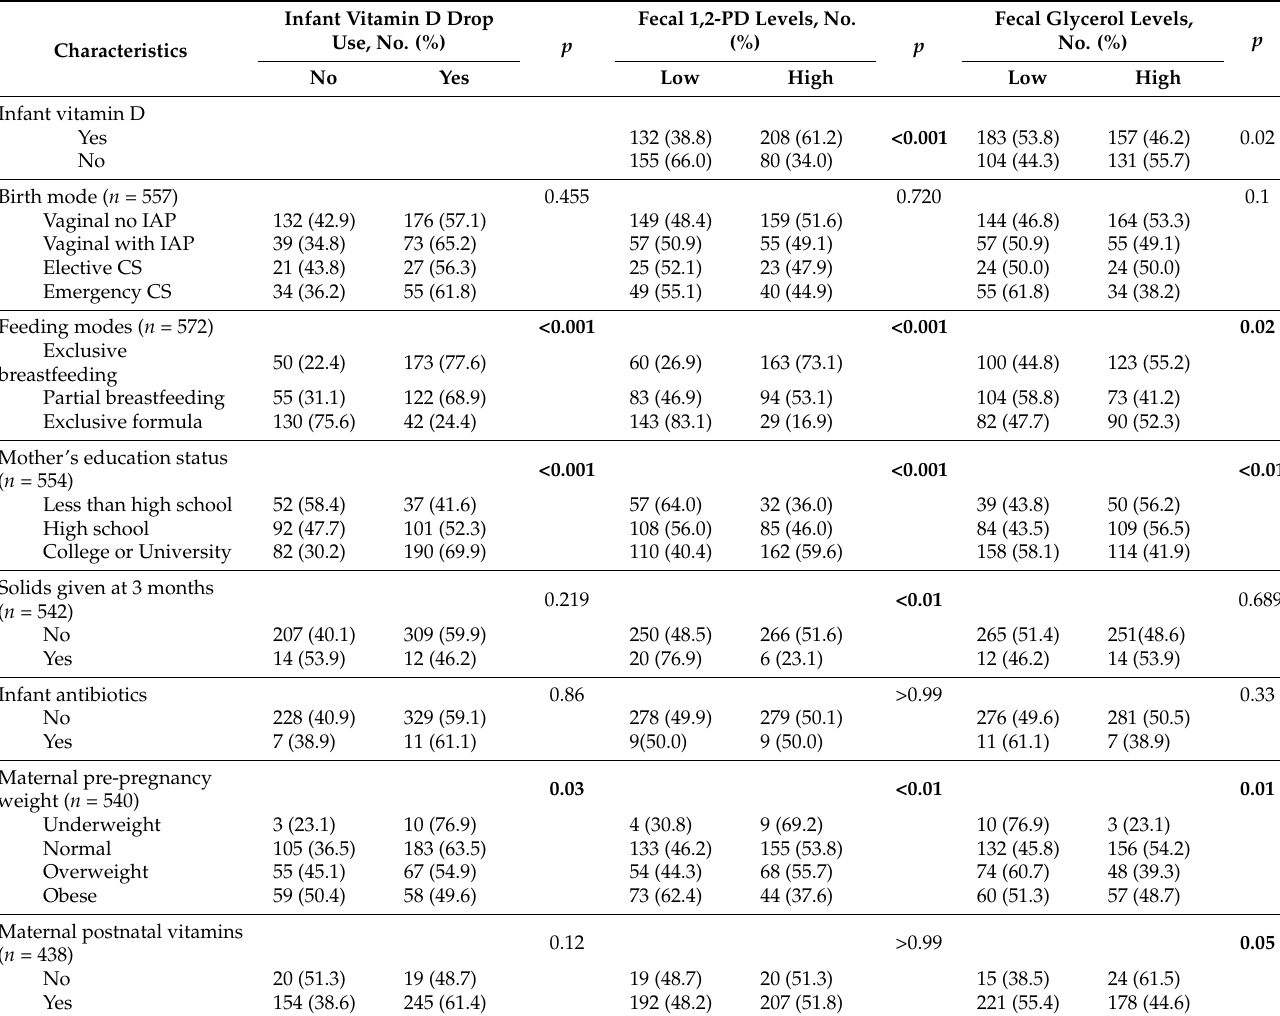
Table 1. Characteristics of the analytic samples according to vitamin D drop usage and fecal 1,2-PD and glycerol levels ( n =